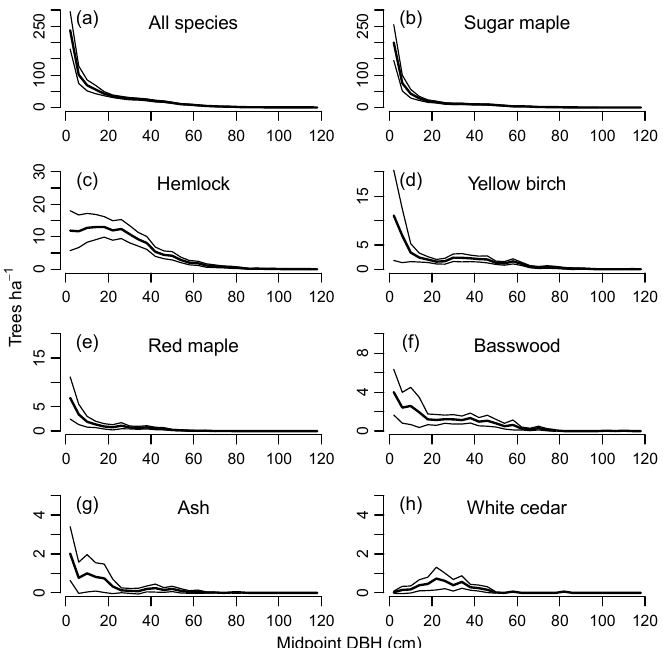
Figure 4. Observed landscape-level diameter distributions for ( a ) all species pooled, and ( b – h ) each of the principal species in the 1981–1984 upper Michigan field survey (70 half hectare plots randomly allocated across 23,000 ha of primary forest). Thick lines give the means among plots, thin lines show a 95% confidence band without a multiple-test correction.